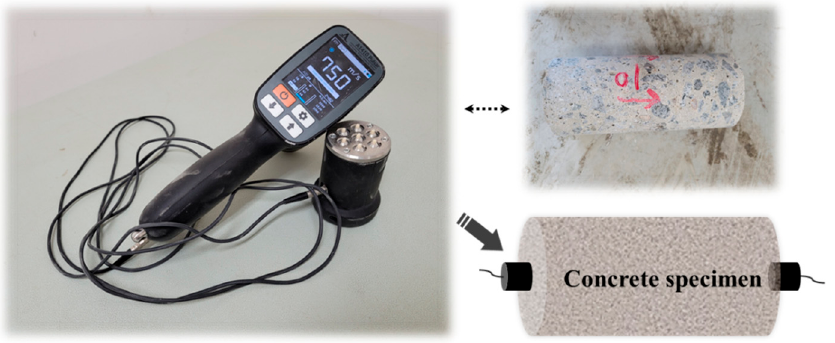
Figure 2. ACS A 1410 Pulsar equipment and direct method to evaluate concrete specimens using ultrasonic velocity.